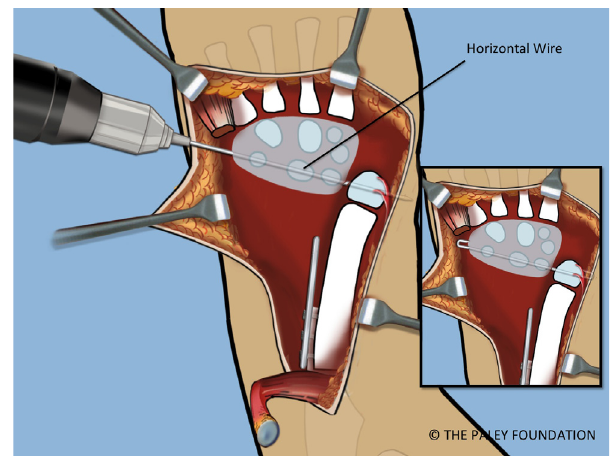
Figure 17. The carpus is pinned to the head of the ulna at station with a transverse 1.5 mm wire starting on the carpal side.